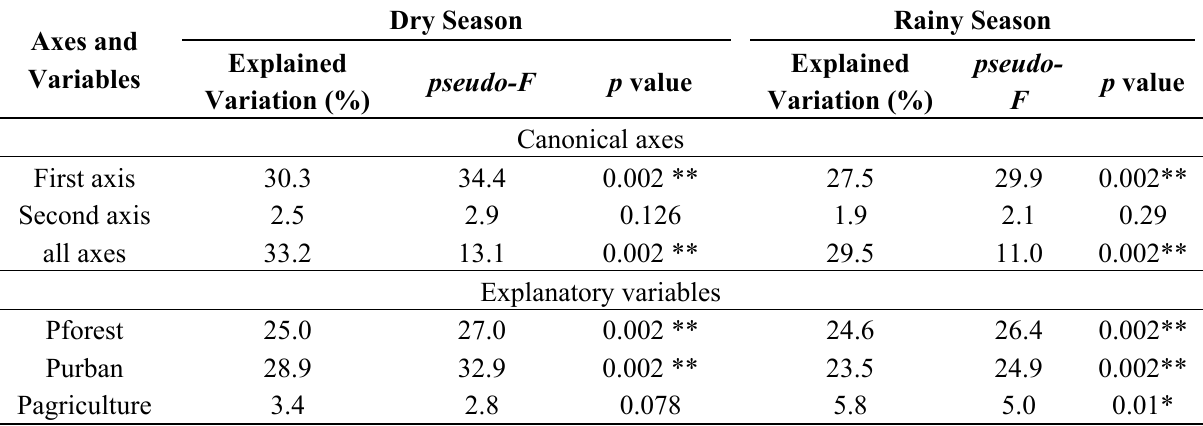
Table 4. Redundancy analysis (RDA) results showing the variance (%) of the water quality parameters explained by canonical axes and explanatory variables.